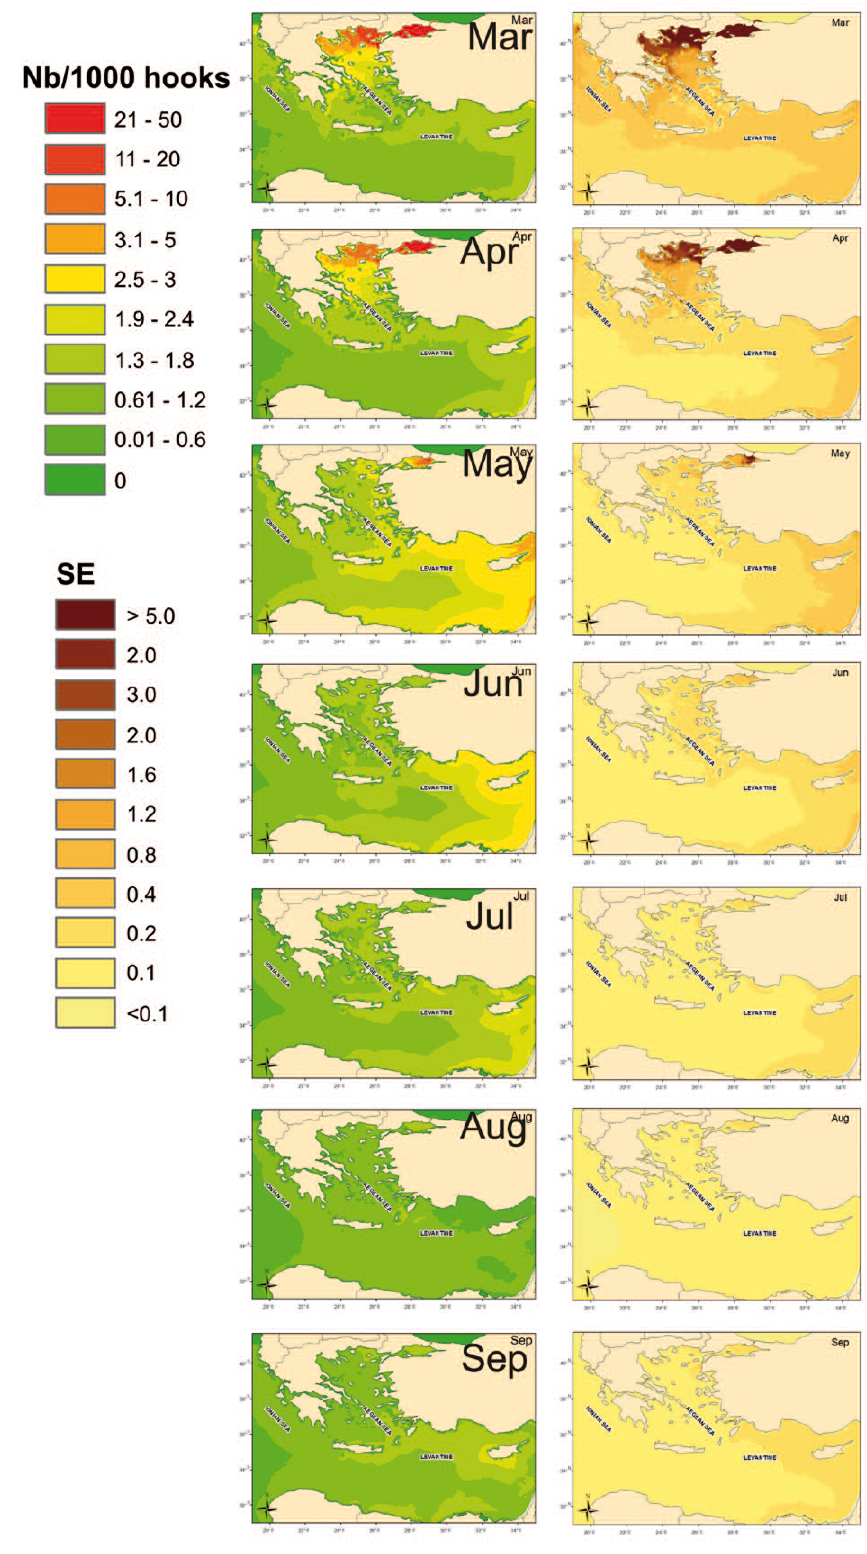
Fig . 5. – Predicted monthly relative abundance (presence only sub-model – number of fish/1000 hooks, left column) and corresponding standard errors (right column), for bluefin tunas in the eastern Mediterranean Sea in 1998-2005. (Predictions refer to a lunar index of 0.5 and American-type swordfish long-line fishing